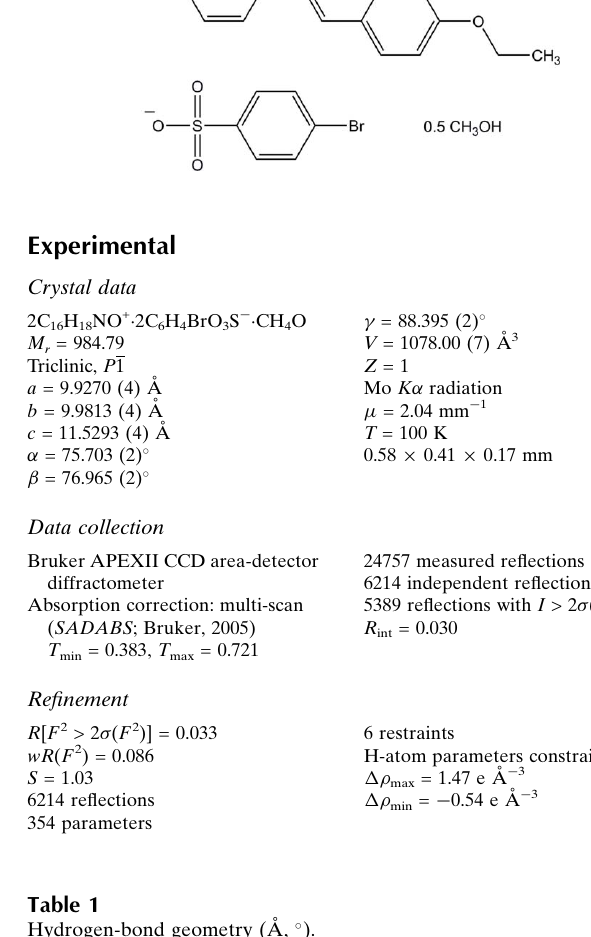
Hydrogen-bond geometry (A˚ , (cid:4)